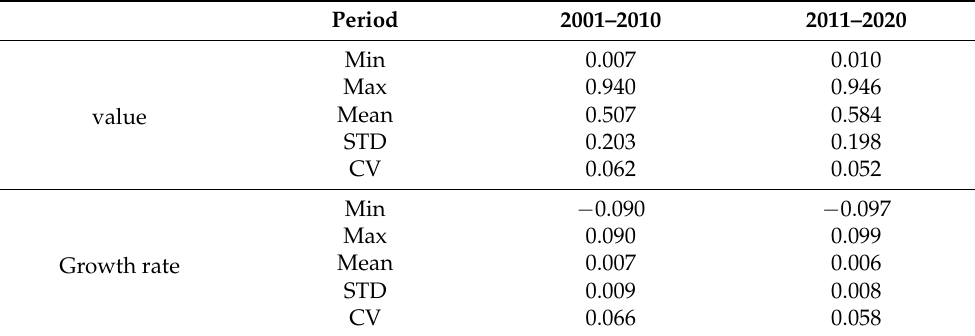
Table 2. Statistical table of the value and growth rate of NDVI in Loess Plateau.